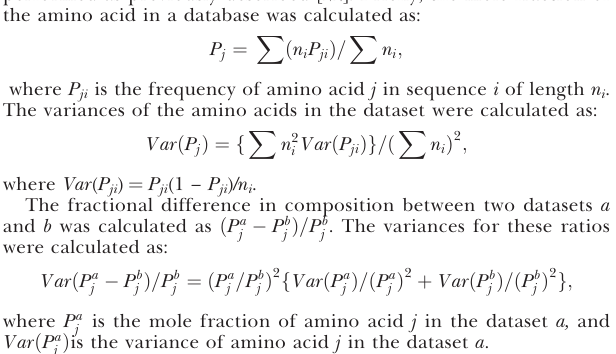
Figure S1. The Percentages of Hub and End Proteins from BioGRID and HPRD with (cid:1) 30 to (cid:1) 100 Consecutive Residues Predicted to Be Disordered 95% confidence intervals were calculated using normal test for two binomial proportions. Found at DOI: 10.1371/journal.pcbi.0020100.sg001 (911 KB EPS). Figure S2. The Percentages of All Interacting Proteins from Four Datasets with (cid:1) 30 to (cid:1) 100 Consecutive Residues Predicted to Be Disordered 95% confidence intervals were calculated using normal test for two binomial proportions. Found at DOI: 10.1371/journal.pcbi.0020100.sg002 (982 KB EPS). Figure S3. The Percentages of All Interacting Proteins from BioGRID and HPRD with (cid:1) 30 to (cid:1) 100 Consecutive Residues Predicted to Be Disordered 95% confidence intervals were calculated using normal test for two binomial proportions. Found at DOI: 10.1371/journal.pcbi.0020100.sg003 (913 KB EPS). Table S1. Properties of Protein Interaction Datasets Derived from BioGRID and HPRD Table S2. Disorder Attributes Calculated for Four Datasets Table S3. Results of a Binary Classification Using Consensus Method on BioGRID and HPRD Datasets The percentages of ordered, disordered, and unclassified proteins in each dataset are